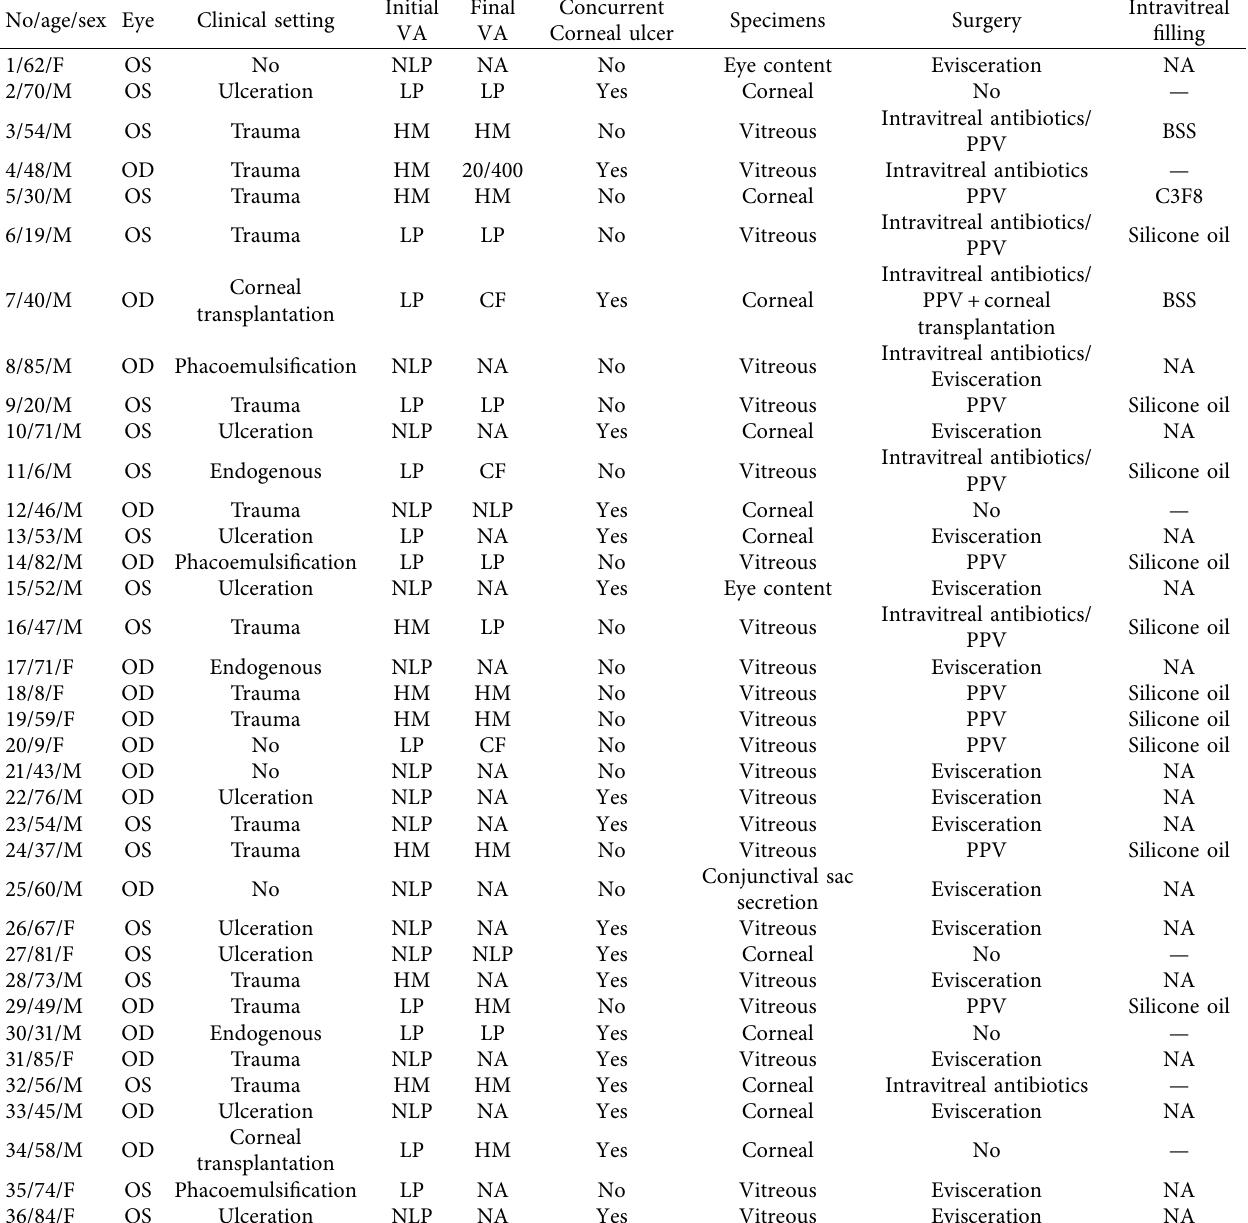
Table 1: Demographic characteristics and outcomes of the 36 patients with Pseudomonas aeruginosa endophthalmitis. No/age/sex Eye Clinical